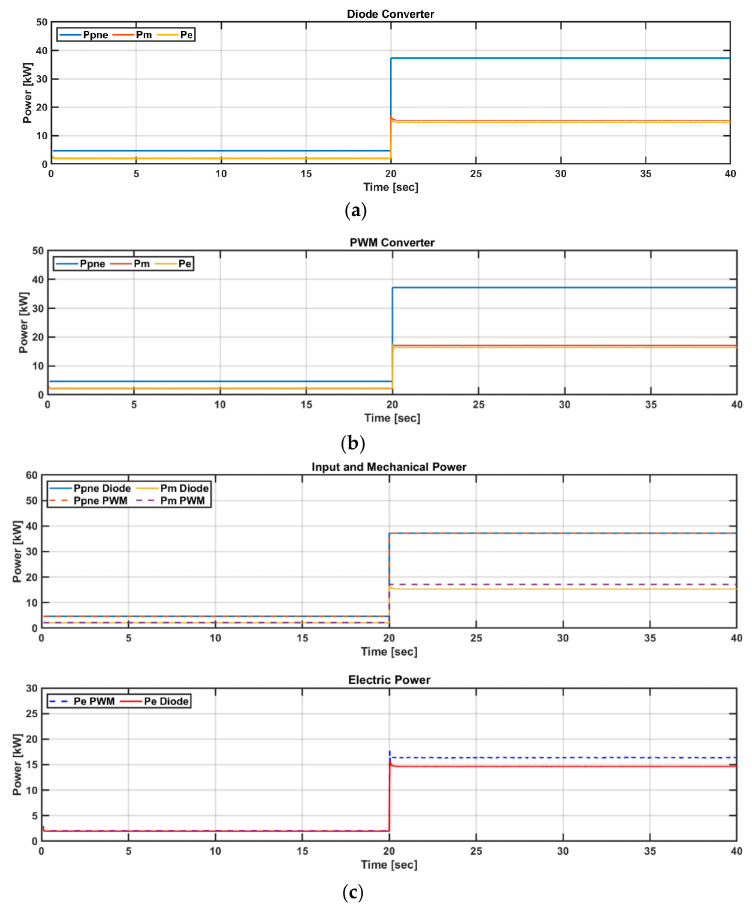
Figure 11. Power result of PTO system in integrated simulation for steady and transient state at constant input flow velocity from 14 m / s to 28 m / s: ( a ) Diode converter, ( b ) PWM converter, ( c ) Comparison of power performance according to